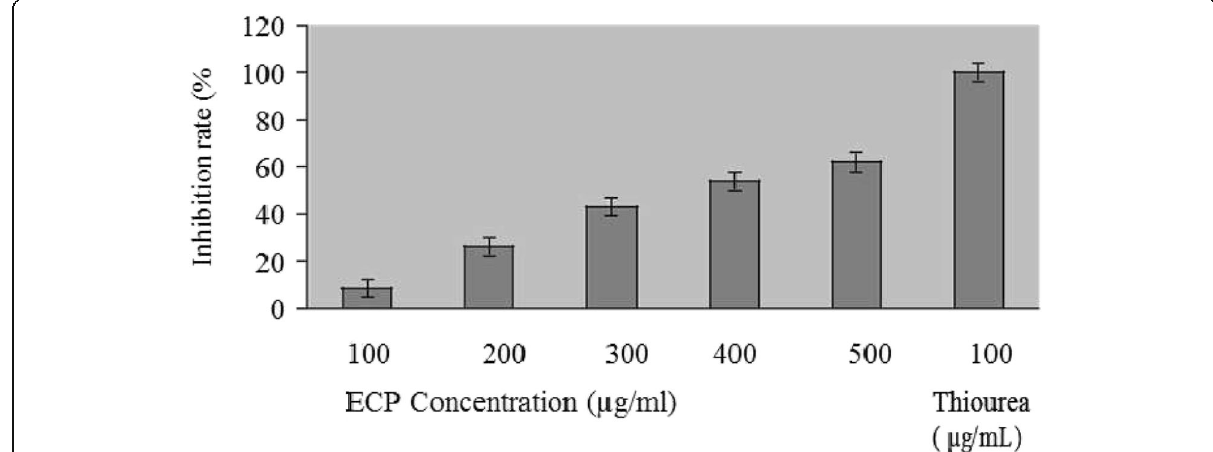
Fig. 2 OH radical scavenging activity of the ECP. Values are means of triplicates ± SD. The rate of inhibition of hydroxyl radical generation by